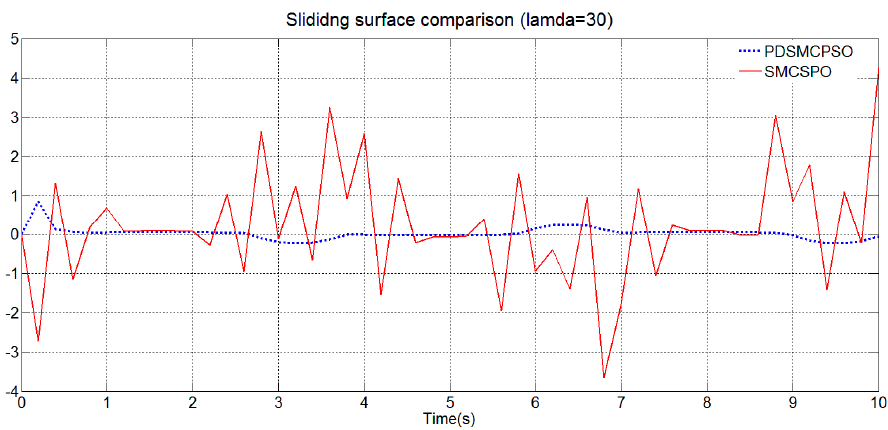
Figure 15. Sliding surface over perturbation of both schemes.